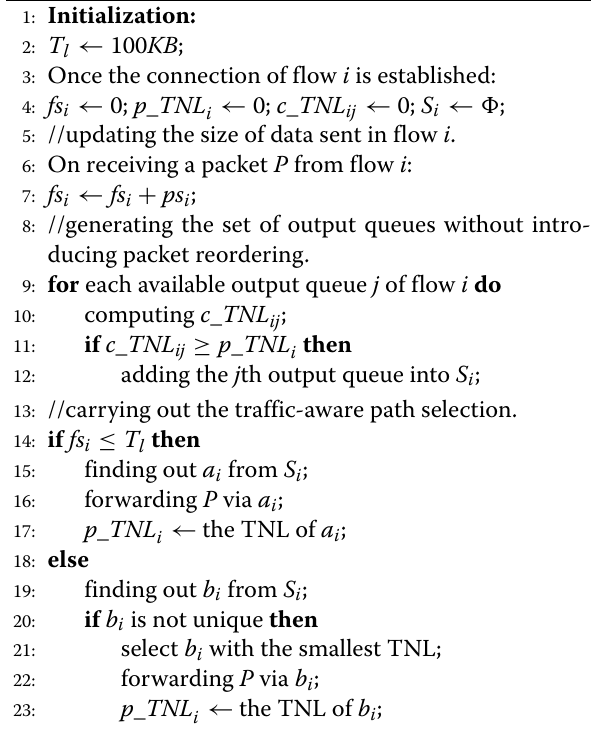
Algorithm 1 Pseudocode of TR: